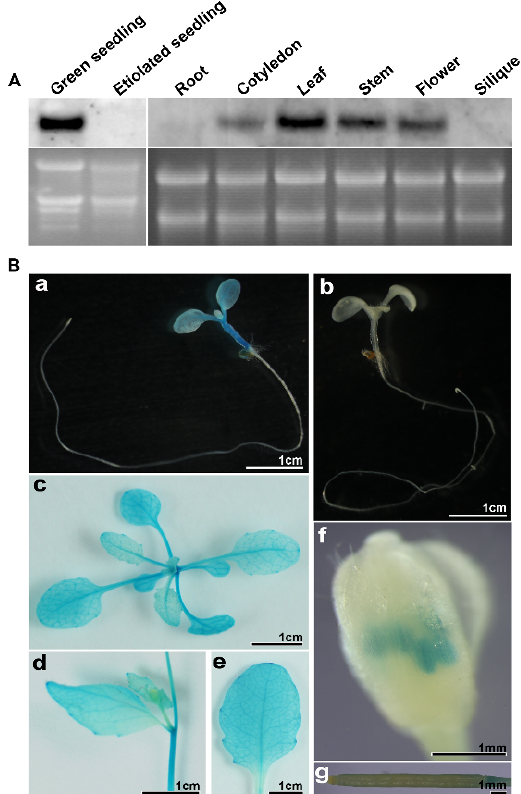
Figure 5. Expression characteristics of the PD1 gene. ( A ) RNA accumulation of the PD1 gene in different tissues and developmental stages. Total RNA was extracted from seven-day-old green seedlings and etiolated seedlings, roots, cotyledons, leaves, stems, flowers, and siliques and under- went formaldehyde electrophoresis and northern blot analyses. 10 μ g total RNA per lane. ( B ) GUS staining of transgenic plants expressing GUS gene driven by PD1 promoter. ( a ) ten-day-old trans- genic seedling expressing GUS gene driven by PD1 promoter. ( b ) ten-day-old seedling transformed pCAMBIA1381Z empty vector. ( c – g ) rosette leaf, stem, cauline leaf, flower, and silique from the transgenic plants expressing GUS gene driven by PD1 promoter.